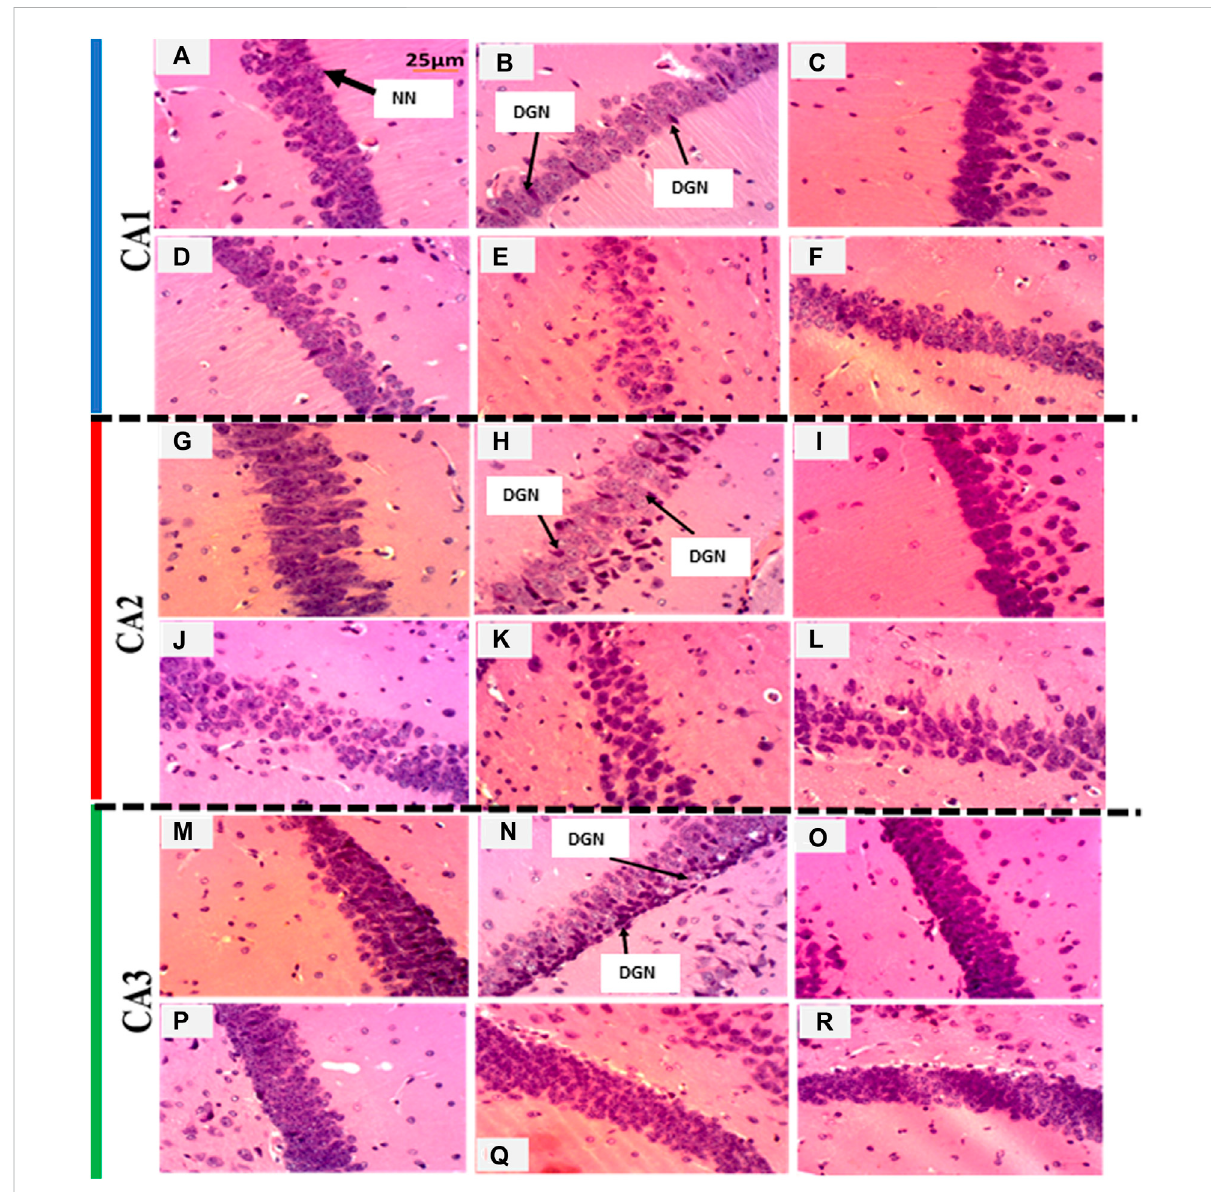
FIGURE 8 The aqueous extract of P. biglobosa attenuated degenerated/necrotic neurons in CA1, CA2, and CA3 regions of the hippocampus after hematoxylin-eosinstaining(200×).Scale:25 µm.DGN:degeneratedneurons;NN:normalneurons;Panels (A,G,M) :normalcontrolgroup;PanelsB, H,andN:negativecontrolgroup;Panels (C,I,O) :sodiumvalproategroup;Panels (D,J,P) :grouptreatedwiththeextractof P.biglobosa atthedoseof 80 mg/kg;Panels (E,K,Q) :grouptreatedwiththeextractof P.biglobosa atthedoseof160 mg/kg;Panels (F,L,R) :grouptreatedwiththeextract of P. biglobosa at the dose of 320